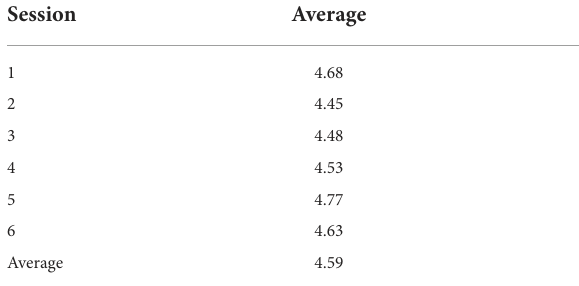
TABLE 4 Findings from iROLL-O fidelity forms.